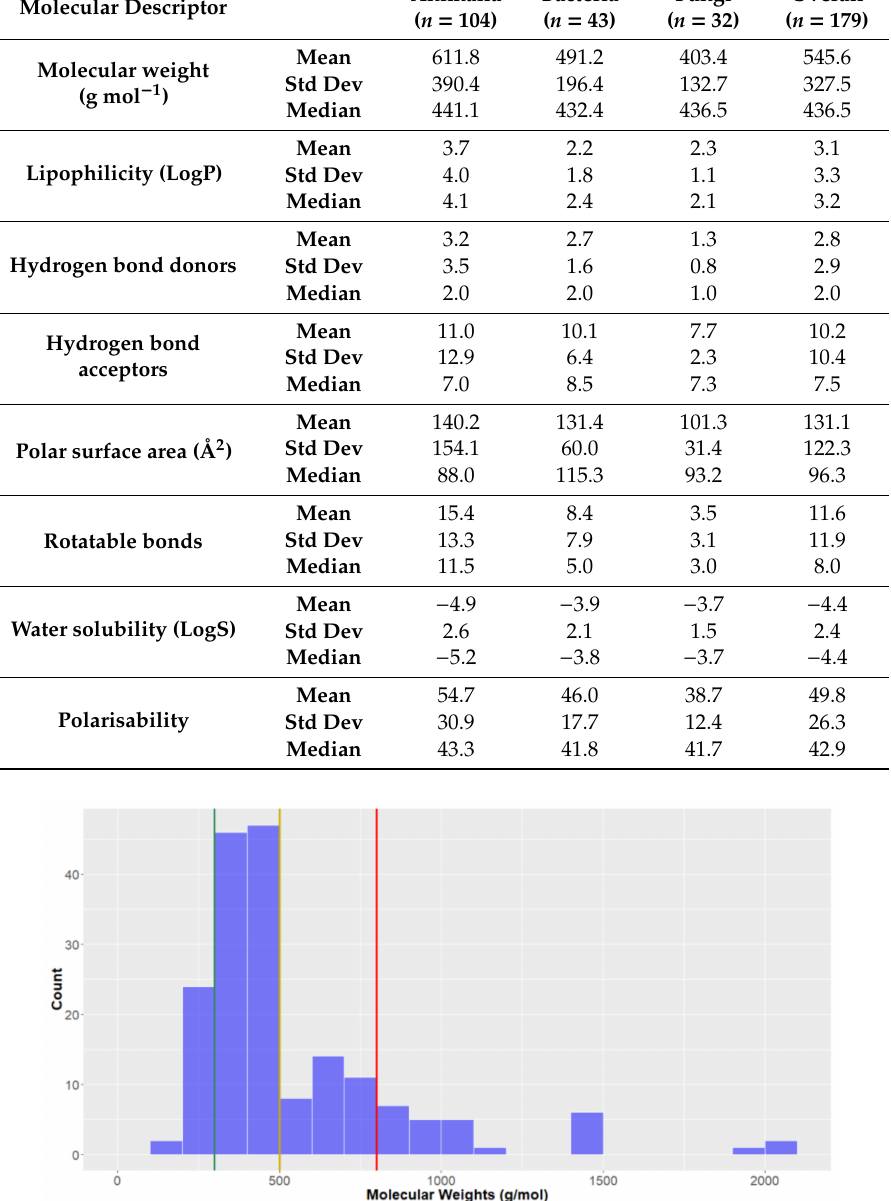
Figure 6. The statistical distribution of the molecular weight of all analysed compounds (green = 300 g mol − 1 , compounds < 300 g mol − 1 are in the lead-like space; yellow = 500 g mol − 1 , compounds < 500 g mol − 1 are in the drug-like space; red = 800 g mol − 1 , compounds < 800 g mol − 1 are in the KDS. Total number of compounds =